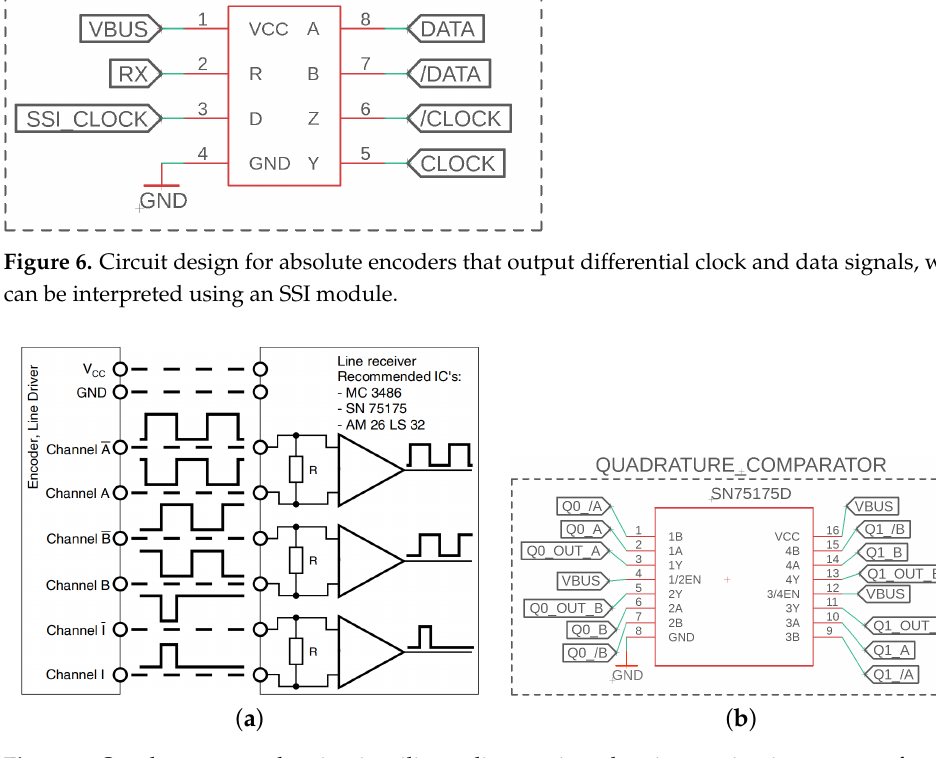
Figure 7. Quadrature encoder circuit utilizes a line receiver that, in practice, is necessary for main- taining channel output integrity to correctly interpret the motor position. ( a ) Line receiver utilized for redundancy (from Maxon catalog [50]). ( b ) Circuit design for quadrature